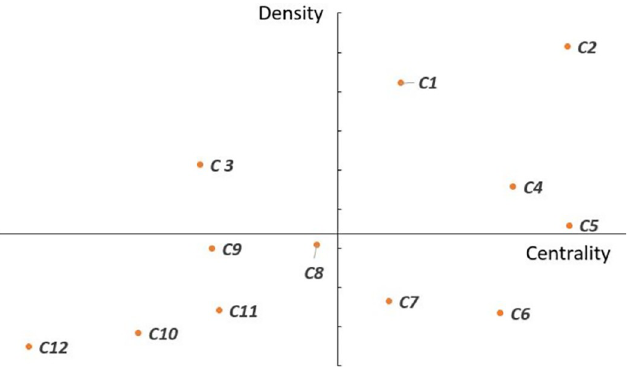
Fig 5. Strategic diagram between 2001 and